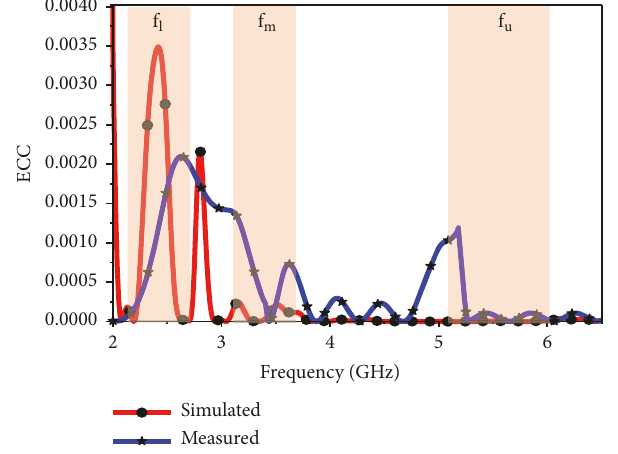
Figure 15: Simulated and measured ECC for proposed MIMO